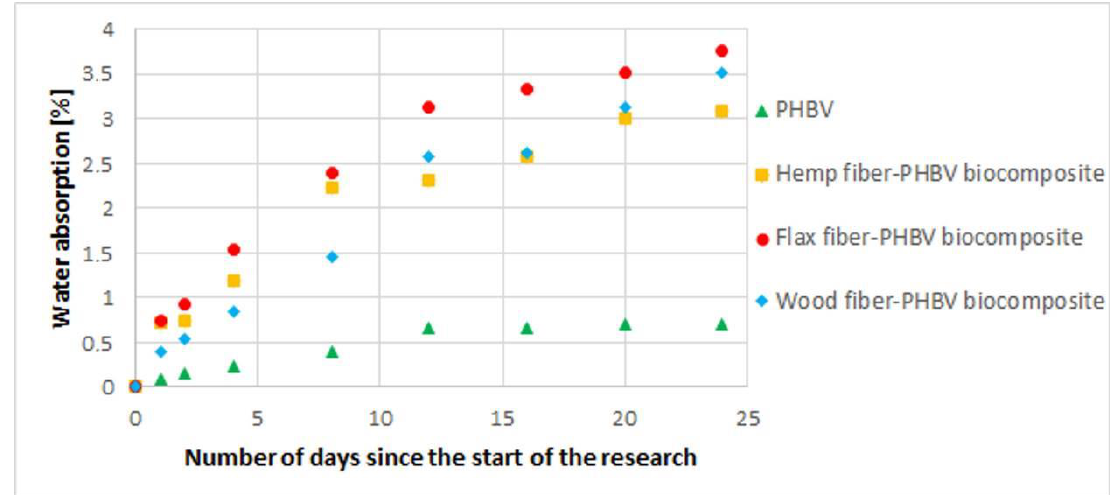
Figure 6. Water absorption for biocomposites with a variable type of filler and for pure PHBV .